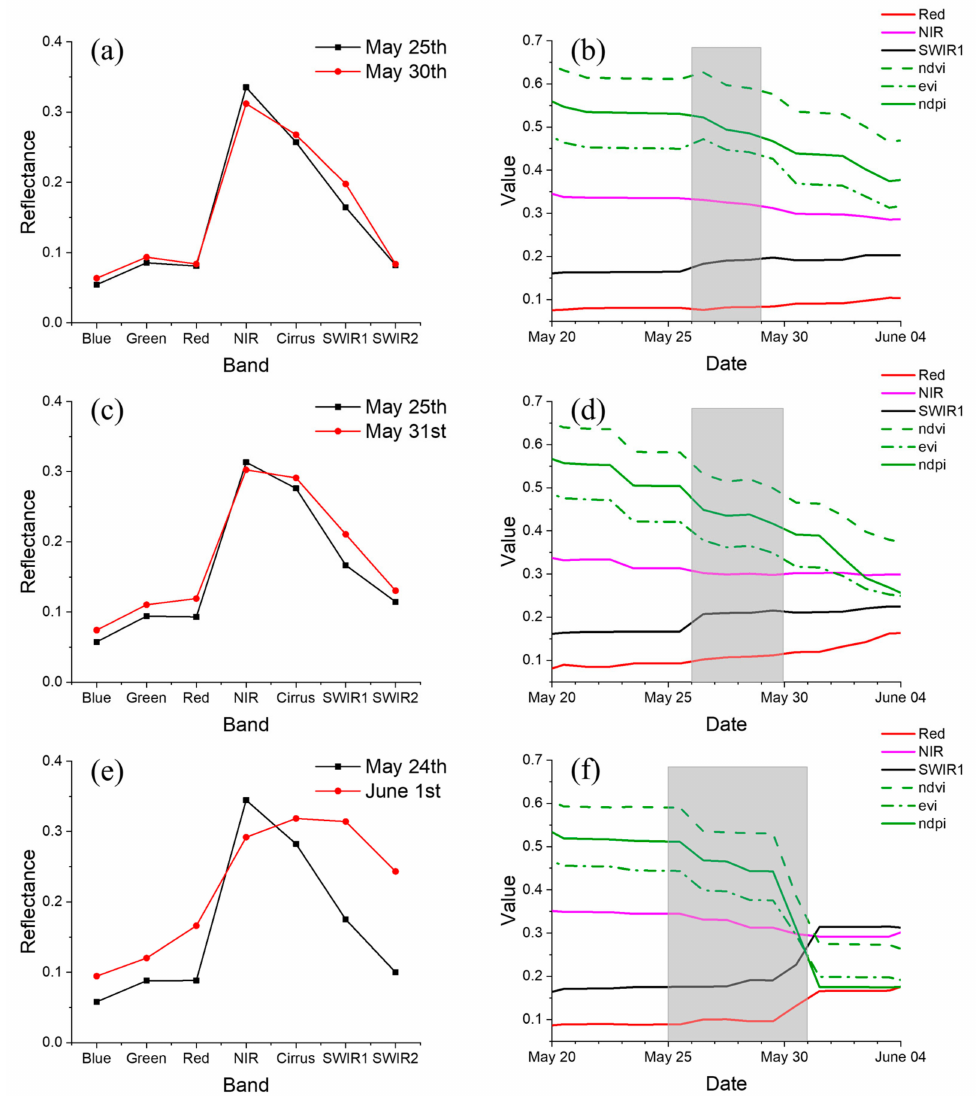
Figure 2. The response of MODIS BRDF-adjusted spectral reflectance (MCD43A4) and VIs to the dry-hot wind. During this period, winter wheat is in grain-filling period. ( a , b ) shows the response to a mild dry-hot wind event, ( c , d ) exhibits the response to a moderate dry-hot wind event, and ( e , f ) represents the response to a severe dry-hot wind event. The gray areas represent the duration of the dry-hot wind